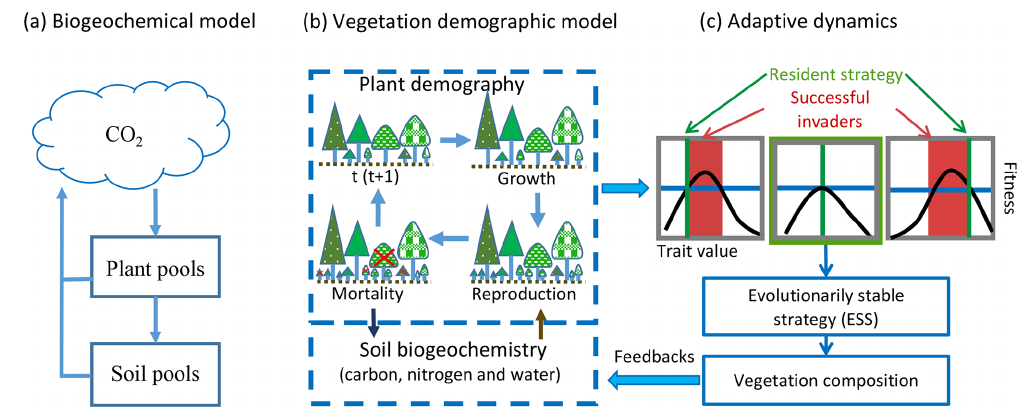
Figure 1. Hierarchical structure of vegetation